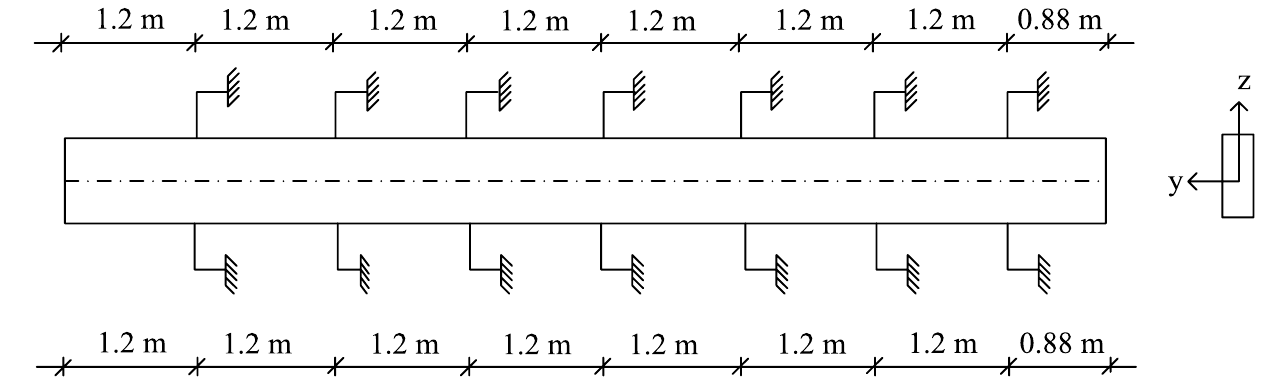
Fig. 6 Discrete bracing of the roof beam at the upper and bottom level of the beam with lateral